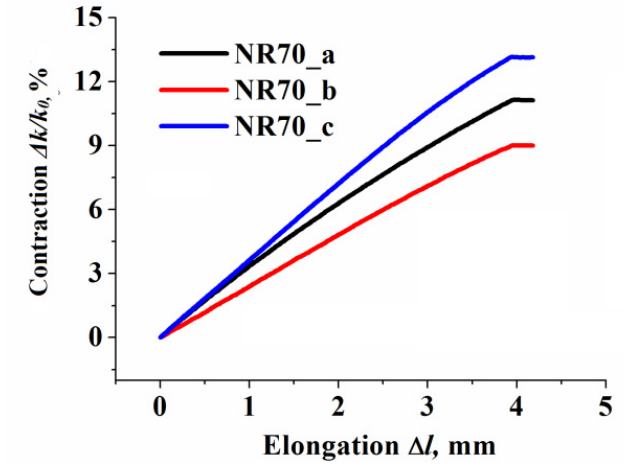
Figure 5. The evolution of elongation vs. contraction for sample containing 70 phr of CB (similar trends were observed for all tested CB concentrations).